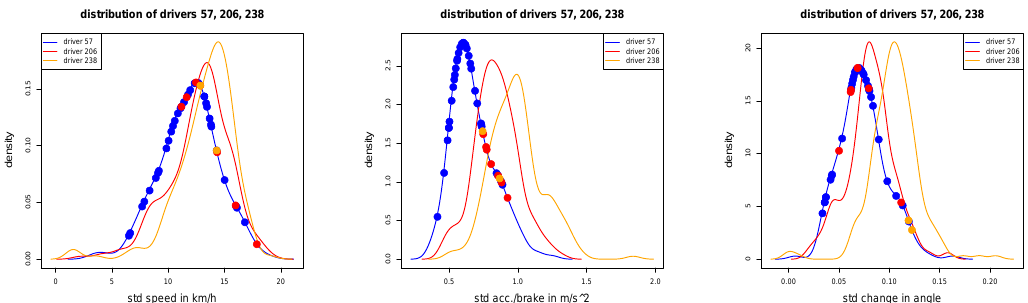
of the time series to perform the clustering.